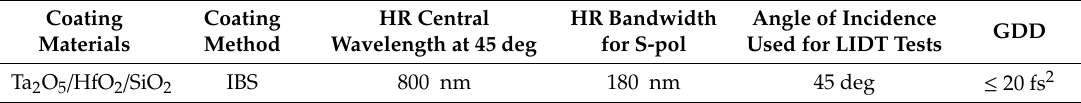
Table 1. Parameters of the tested MLD